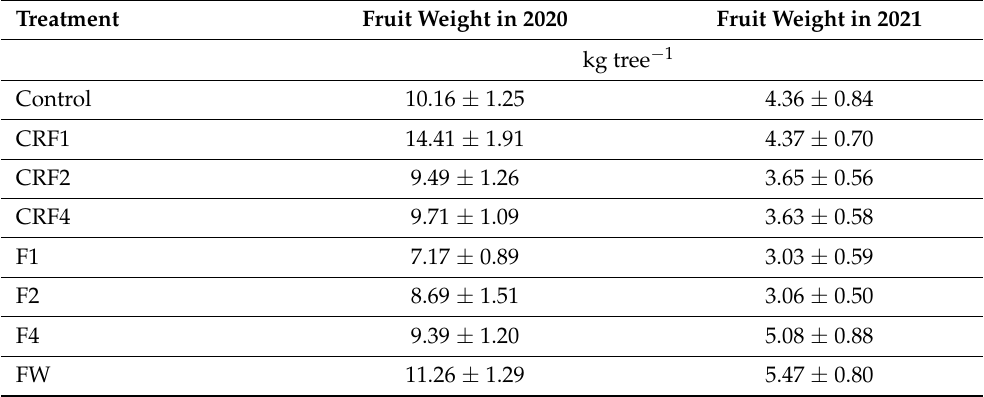
Table 6. Fruit weight per tree for 2020 and 2021. A one-way analysis of variance (ANOVA) with a Tukey honestly significant difference (HSD) test was used to determine significant differences between means. Data represents means ± standard